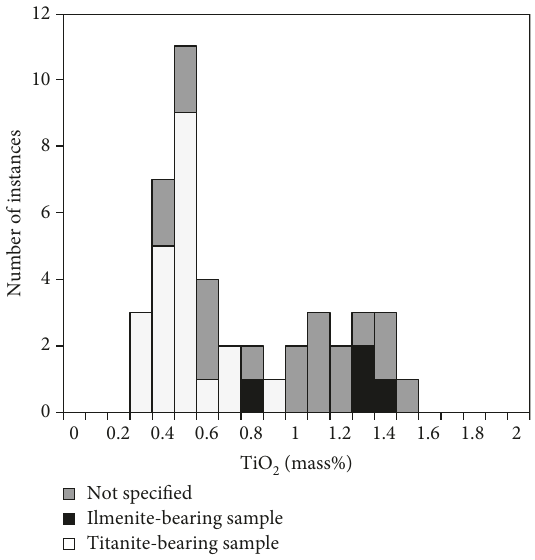
Figure 6: Frequency of TiO coexisting titanium